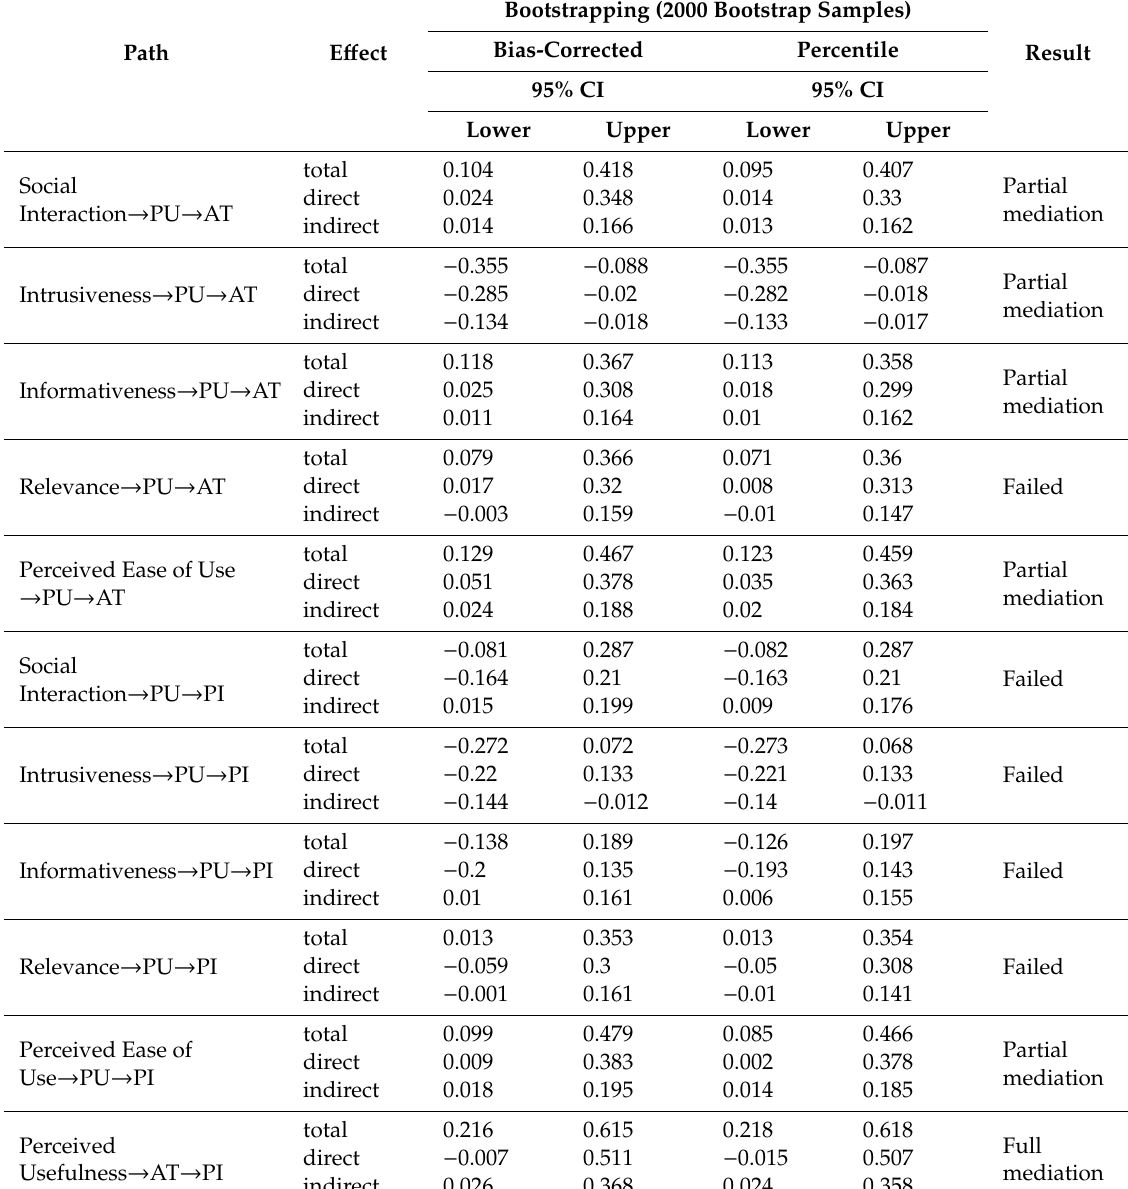
Table 6. Mediating e ff ects